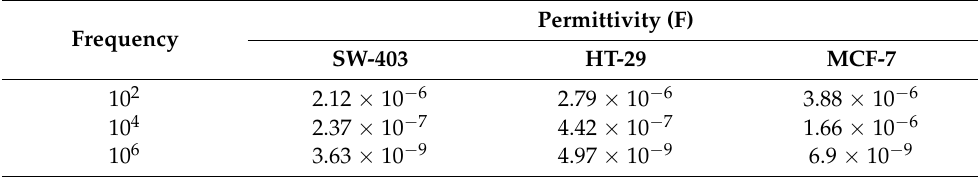
Table 3. Real permittivity as a function of frequency for different tumor cells: MCF-7, SW-403 and